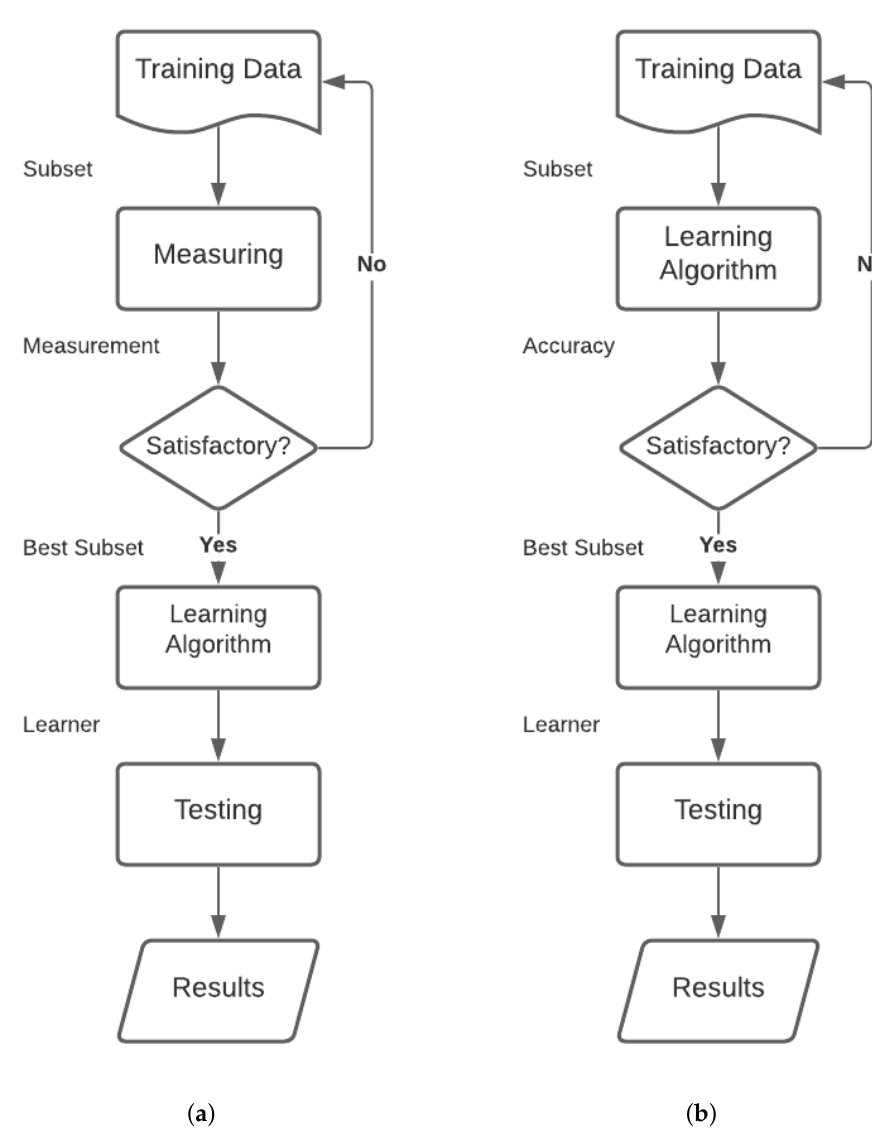
Figure 4. Workflow of the ( a ) filter-based and ( b ) wrapper-based feature selection